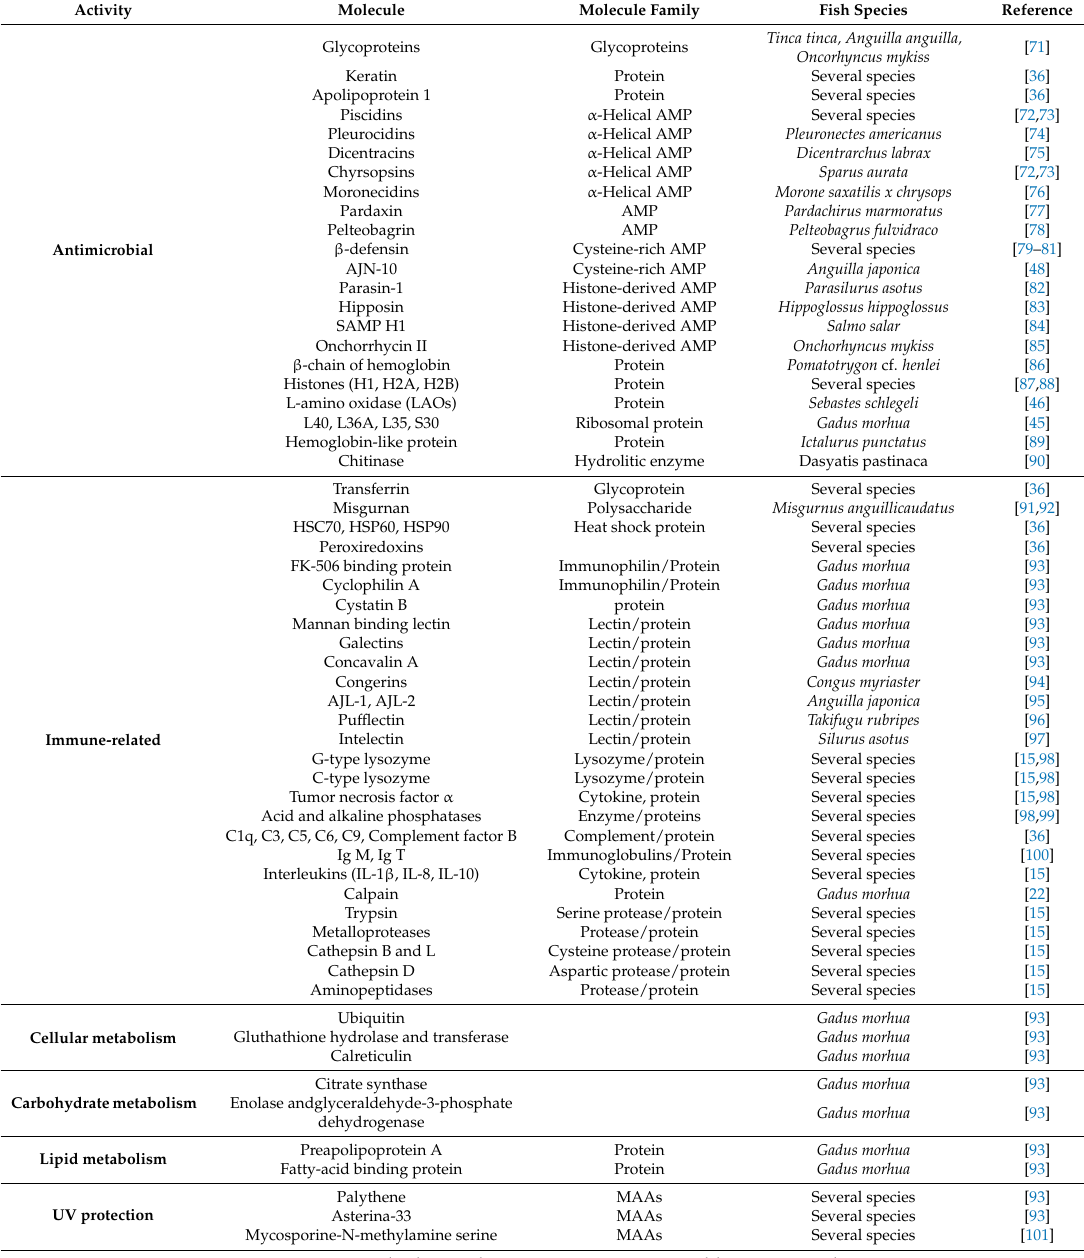
Table 1. Biological activities of fish mucus molecules. If molecules are reported in more than three fish species, species are not